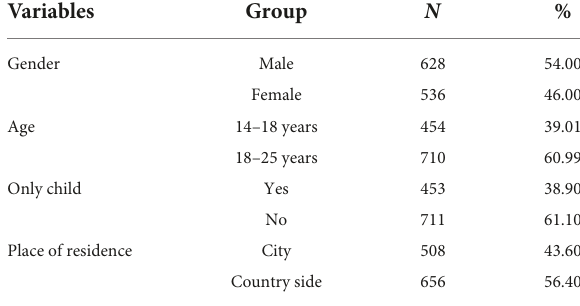
TABLE 1 Sociodemographic characteristics ( N =